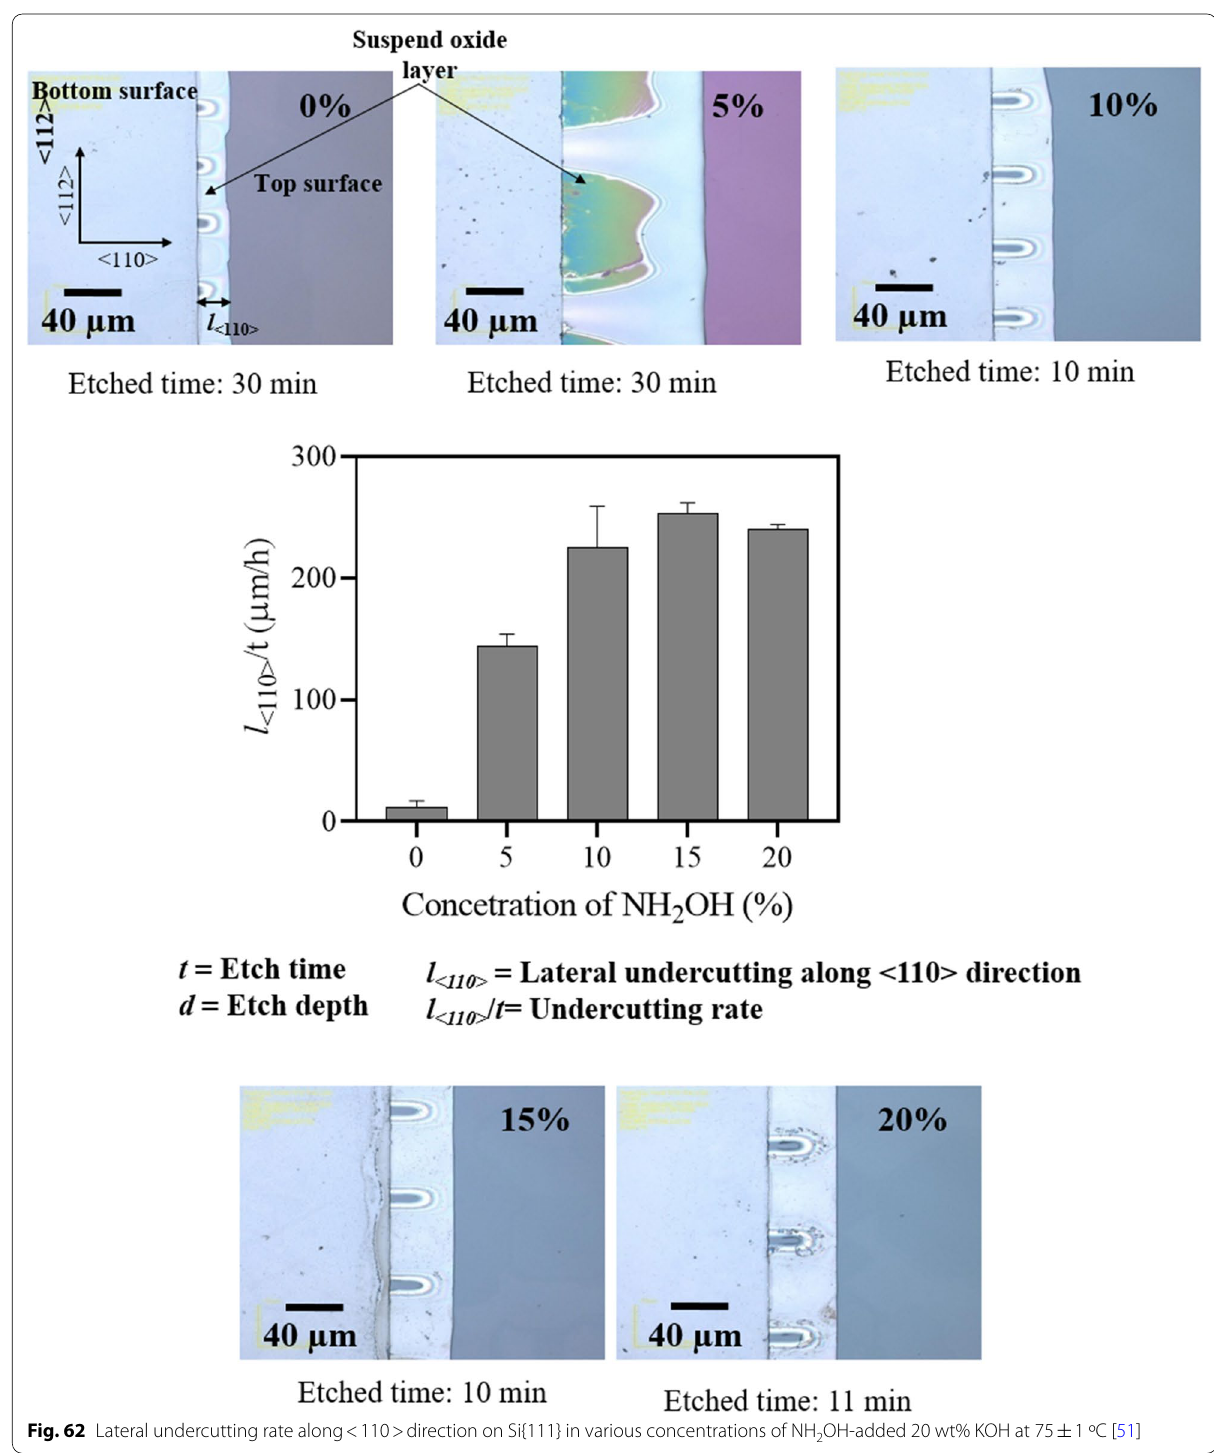
Fig. 62 Lateral undercutting rate along < 110 > direction on Si{111} in various concentrations of NH 2 OH-added 20 wt% KOH at 75